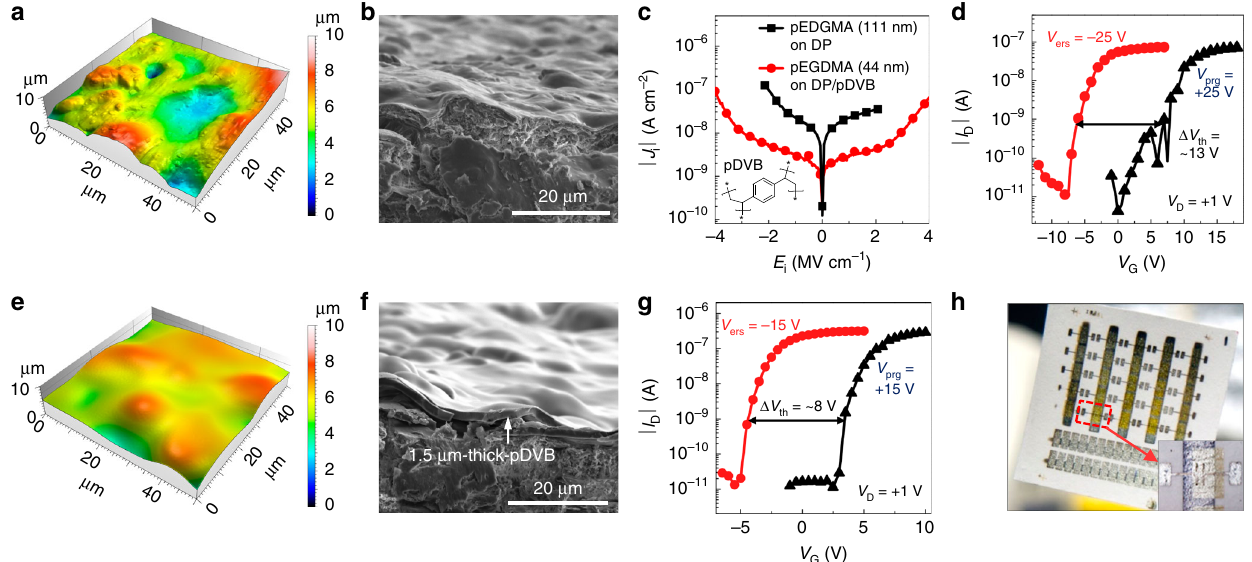
Fig. 4 Organic fl ash memories on papers for disposable electronics. a , b Surface and cross-sectional morphologies of a pristine dye-sublimation paper (DP) characterized with atomic force microscopy (AFM) and scanning electron microscopy (SEM). c J i – E i characteristics of pEGDMA layers measured from Al/ pEGDMA (111 nm)/Al devices fabricated on a pristine DP ( black line with squares ) and that of Al/pEGDMA (44 nm)/Al on a pDVB-coated DP. The molecular structure of pDVB is shown in the inset . d Transfer memory characteristics of a fl ash memory fabricated on a pristine DP ( d BDL = 111 nm). e , f Surface and cross-sectional morphologies of the pDVB-coated DP. g Transfer memory characteristics of a fl ash memory fabricated on a pDVB-covered DP ( d BDL = 44 nm). h A photograph of the proposed paper-based organic fl ash